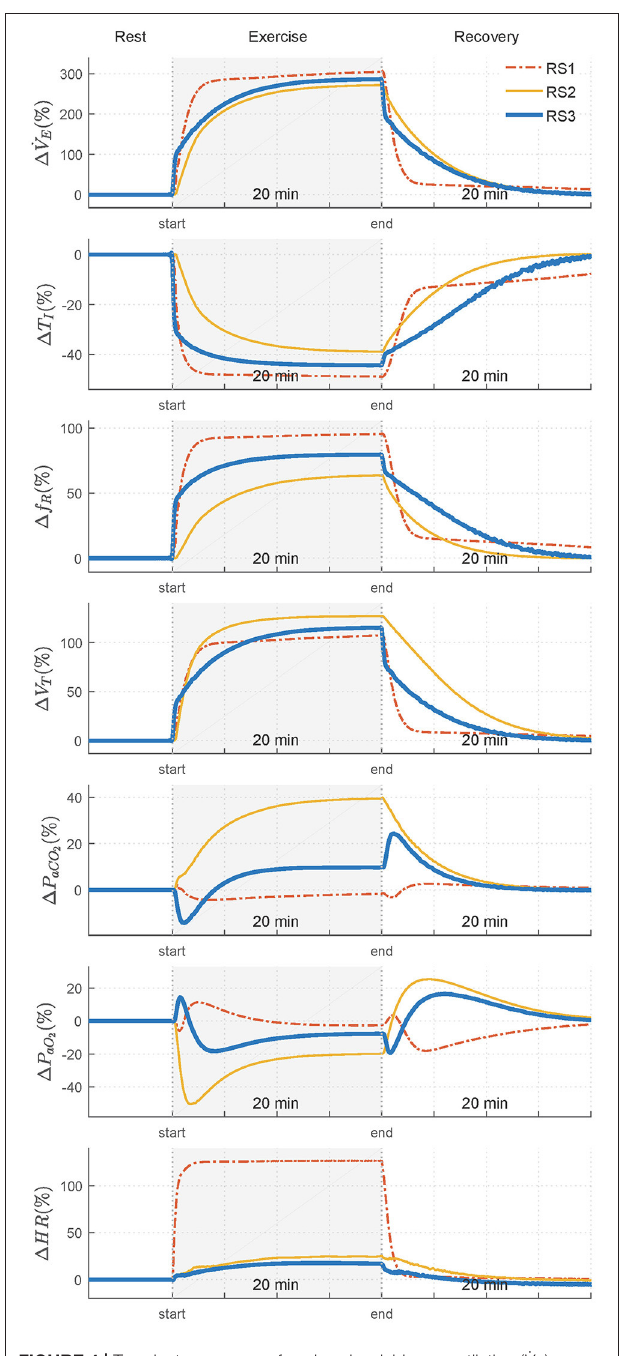
FIGURE 4 | Transient responses of analyzed variables—ventilation ( ˙ V E ), inspiratory time ( T I ), respiratory frequency ( f R ), tidal volume ( V T ), arterial CO 2 pressure ( P aCO ), arterial O 2 pressure ( P aO ), and heart rate ( HR )—when a 2 2 = 1.50 L/min) was used to = 1.20 L/min and ˙ V O step exercise input ( ˙ V CO 2 2 simulate RS1, RS2, and RS3. Variations of each variable are showing regarding their respective values in rest.